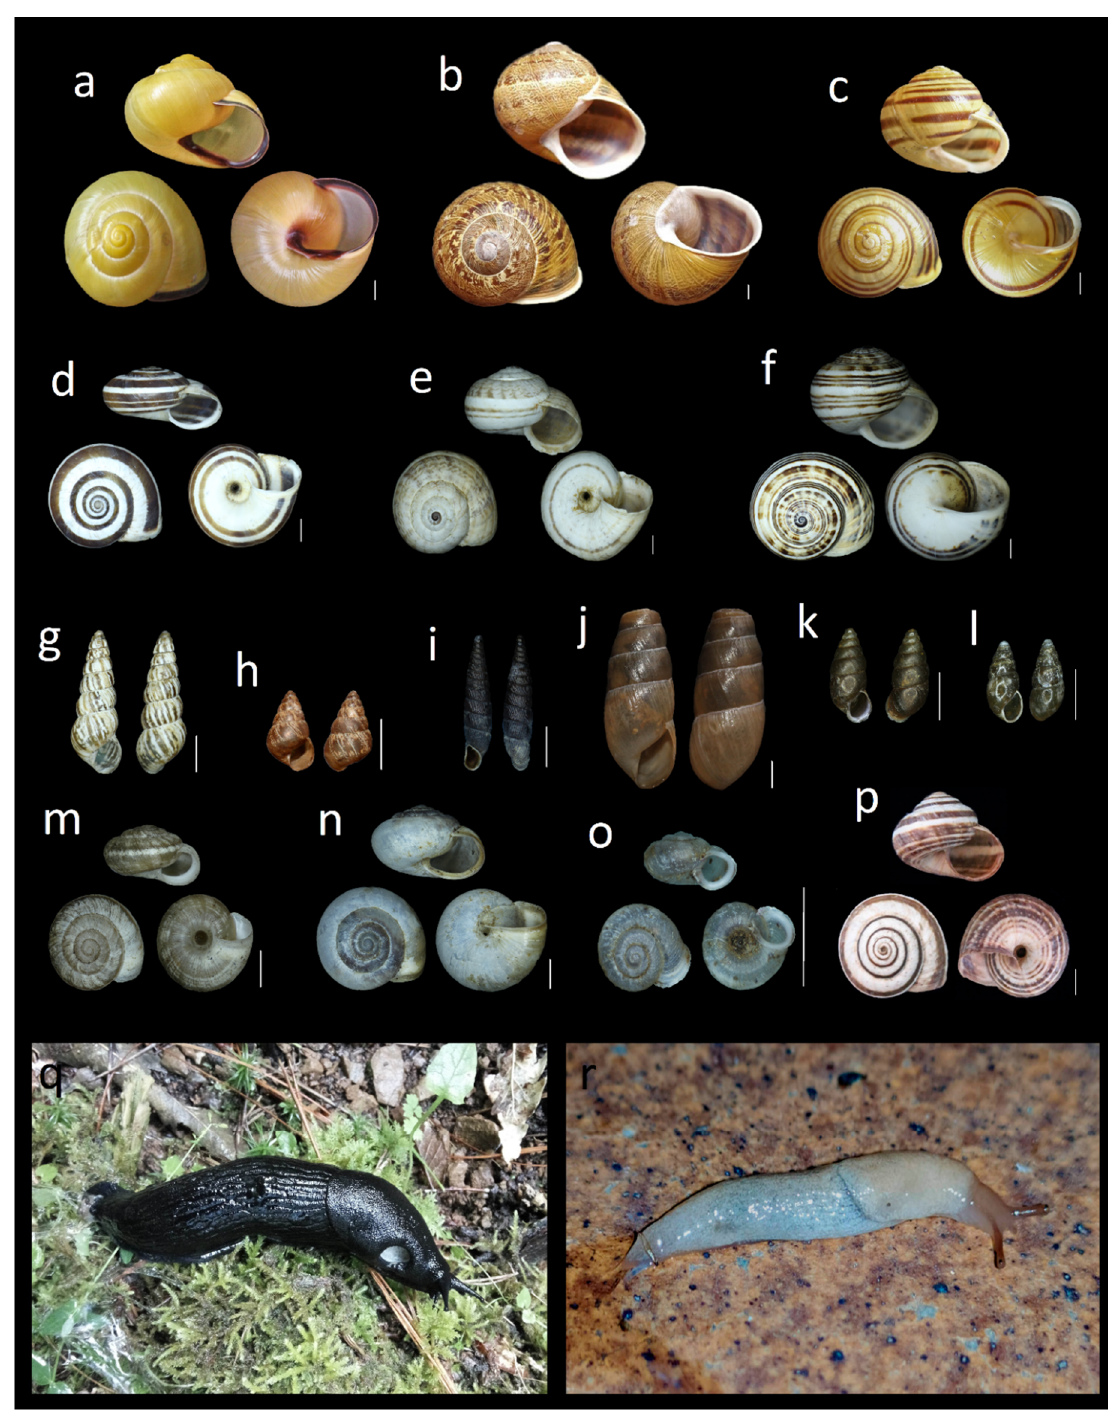
Figure 5. Intermediate freshwater gastropod hosts of trematodes in Asturias. ( a ) Sinotaia cf. quadrata (Nora River-Oviedo), ( b ) Lymnaea stagnalis (Villanueva de Oscos pond), ( c ) Stagnicola cf. palustris (spring in Lugones-Siero), ( d ) Omphiscola glabra (temporary pond in Avilés), ( e ) Melanoides tuberculata (Nora River-Oviedo), ( f ) Ampullaceana balthica (Trubia River- Oviedo), ( g ) Radix auricularia (Trubia River-Oviedo), ( h ) Radix cf. labiata (Bascones River-Grado), ( i ) Bithynia tentaculata (Embalse de Valduno–Las Regueras), ( j ) Galba truncatula (Bascones River-Grado). All scale bars 1 cm.